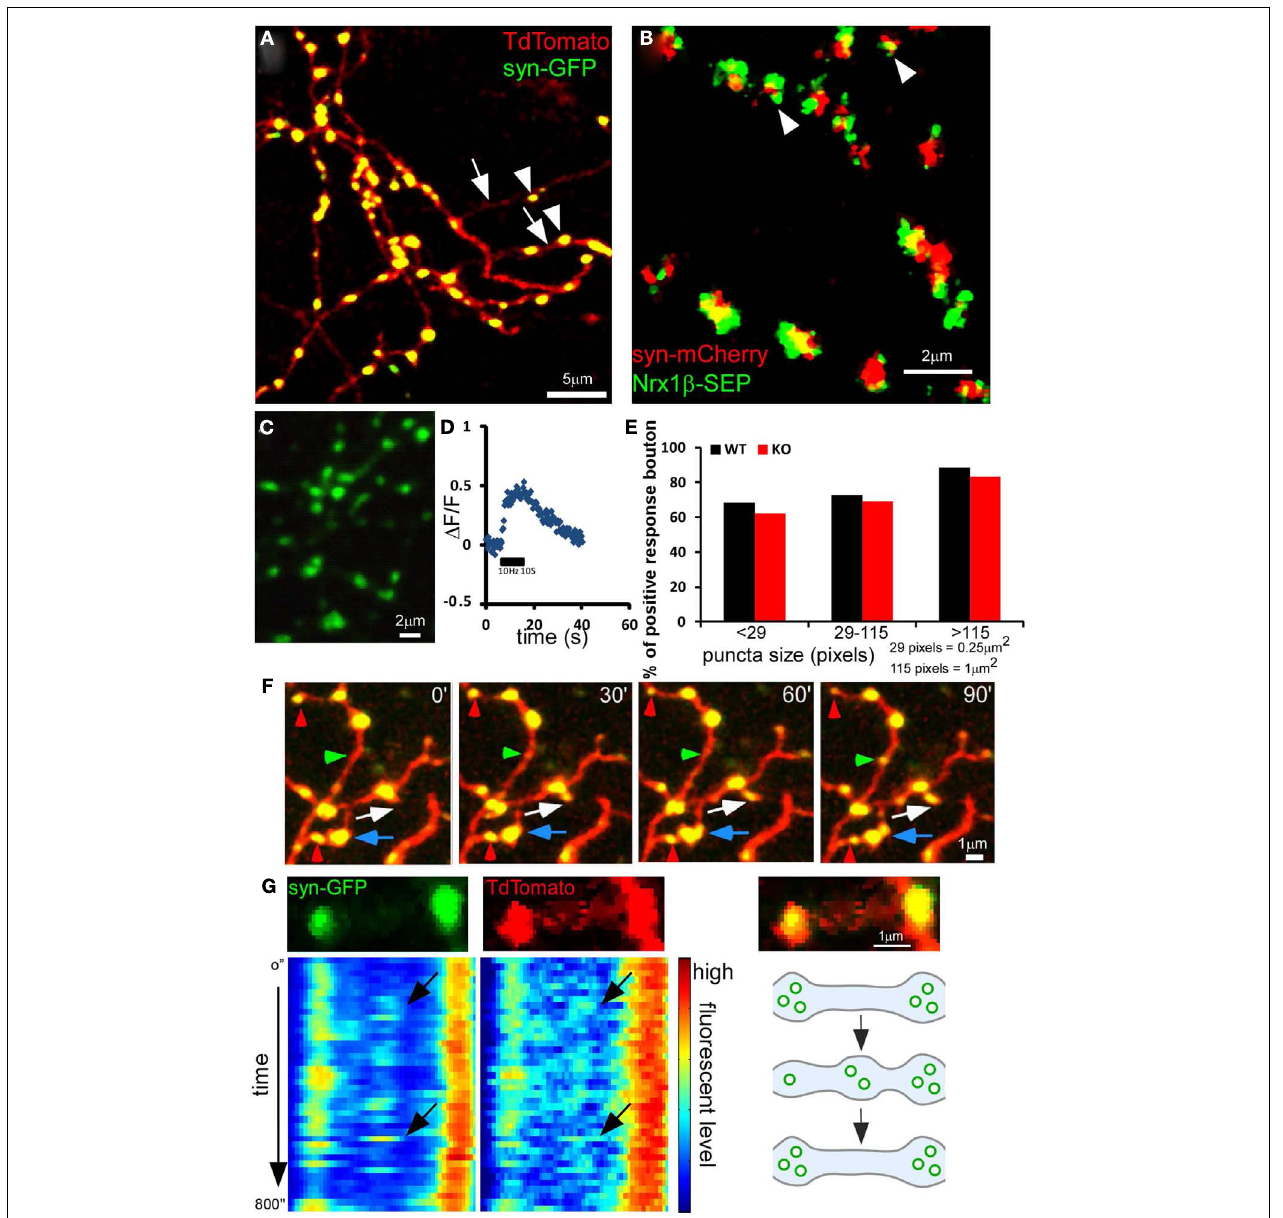
boutons from seven cells) and GABA B1flx/flx ::PV-ires-Cre slice culture (218 boutons from seven cells). Fisher’s-exact test of the proportion of functional boutons in bothWT and GABA B R KO neurons in different size population showed no significant difference. (F) Axon terminals in (A) were imaged at 30min intervals. Red arrowheads indicate boutons that shrink and diminish their syn-GFP signal. Green arrowheads indicate bouton that enlarge and accumulate syn-GFP.The blue arrow indicates newly formed boutons that split from a larger bouton.The white arrow indicates a newly formed bouton on a newly grown branch. (G) The dynamics of syn-GFP puncta closely correlated with that ofTdTomato.The top row shows a small portion of an axon branch bearing two boutons (TdTomato) containing syn-GFP puncta (left) and the merged view (right).The kymographs show the dynamic changes of syn-GFP andTdTomato signal in the two boutons in a 800-s movie with 20s interval. Each horizontal line in the kymograph represents the signal from one time point. Note the moment-to-moment correspondence of signal fluctuations in syn-GFP andTdTomato (black arrows).The bottom right panel shows a schematic of the dynamic changes in (G)